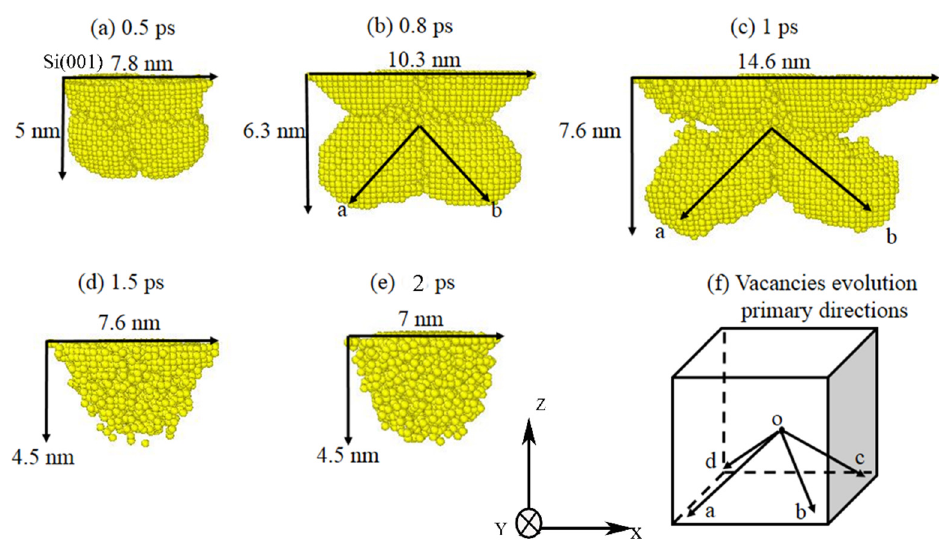
Figure 4. Cross-sectional views of the primary directions of vacancies’ evolution in the silicon target during 0.5 keV Si 35 cluster implantation from 0.5 ps to 2 ps. The yellow dots represent vacancies. The top surface is the Si (001) plane. The directions of ( a – d ) in ( f ) are the primary directions of vacancies’ evolution.